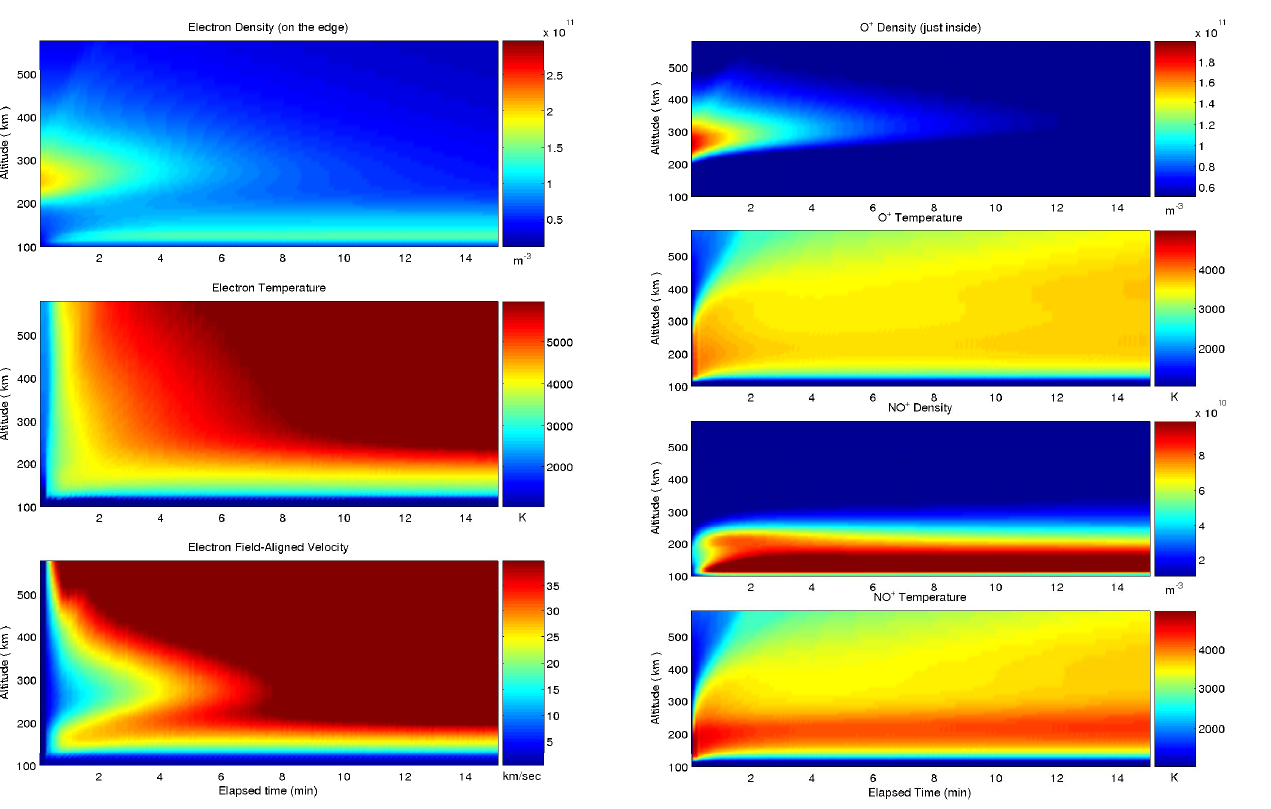
Fig. 6. Time evolution of ion parameters just inside the precipitation zone, where E -region conductivities reach their largest